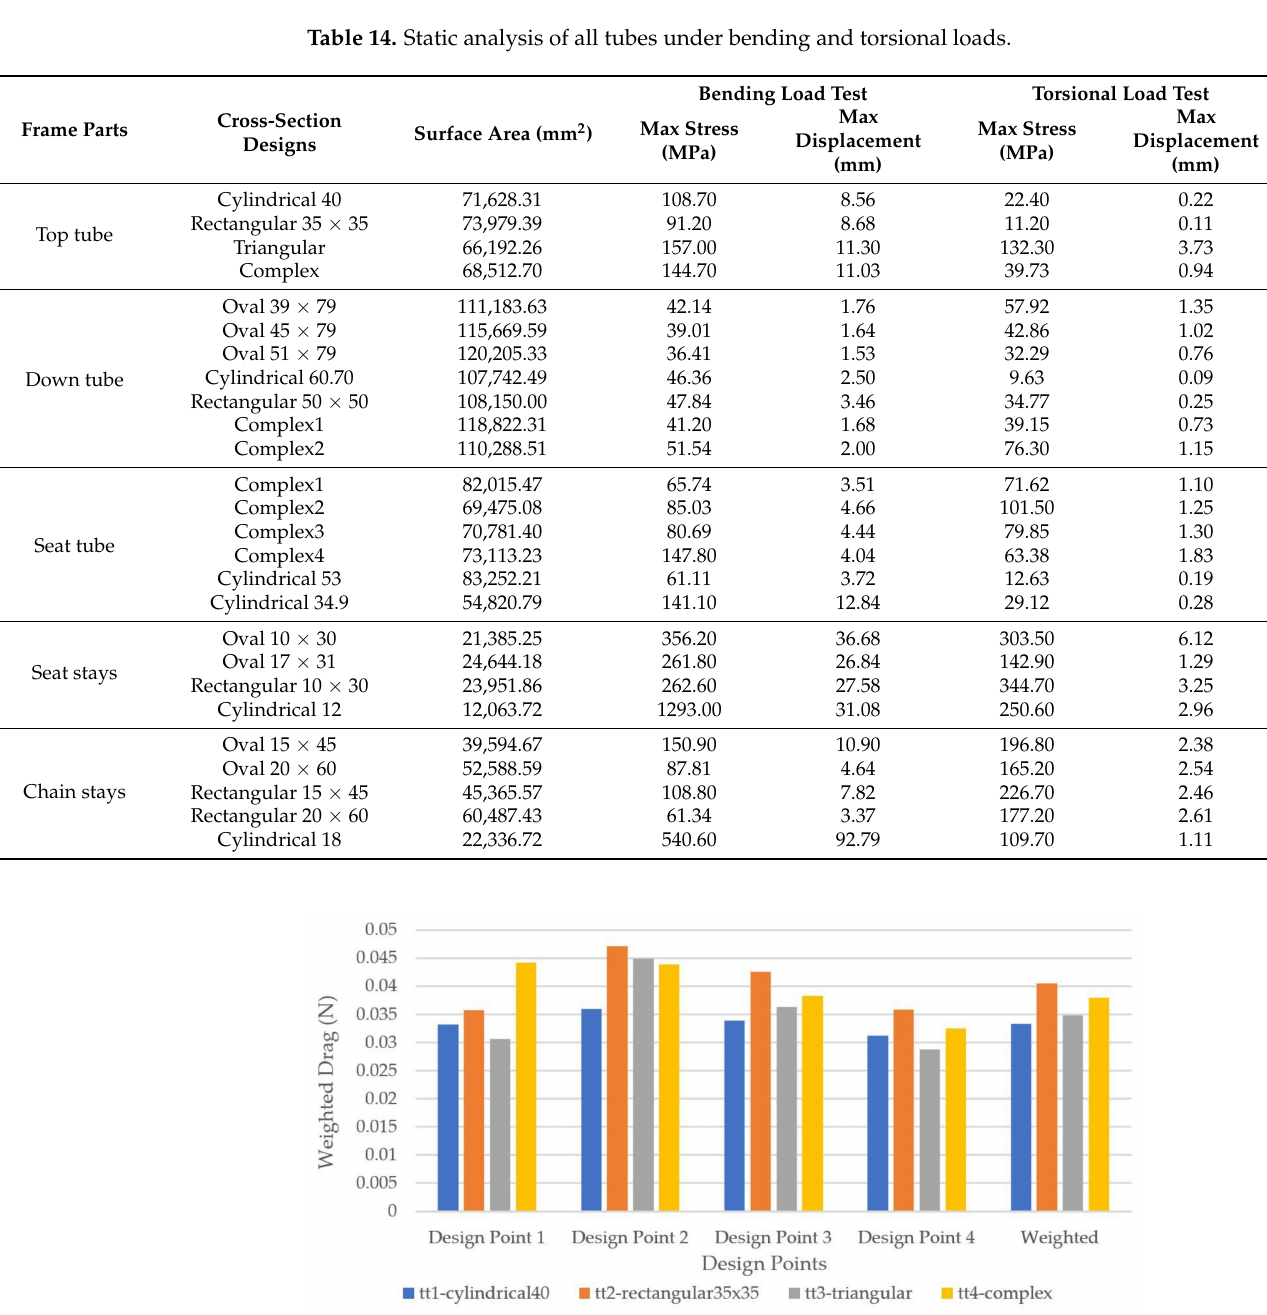
Figure 26. Weighted drag on top tube